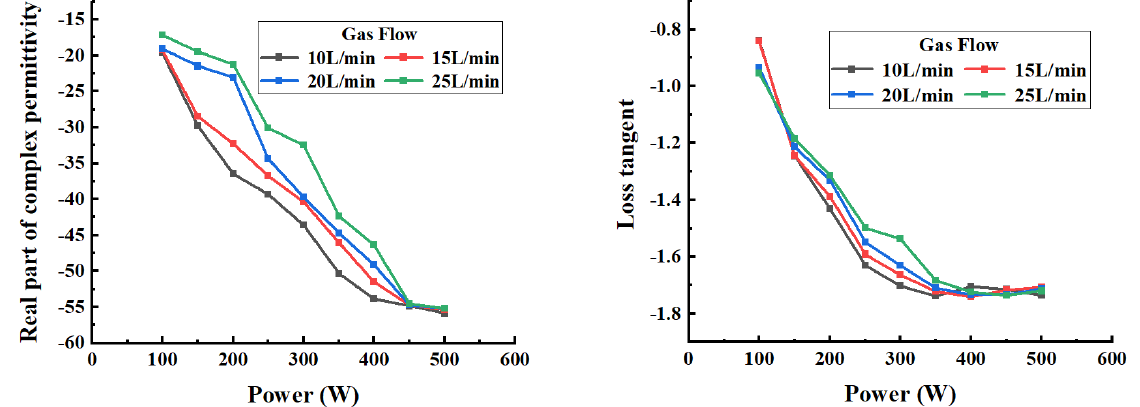
Figure 7. S parameters corresponding to different power and gas flow.